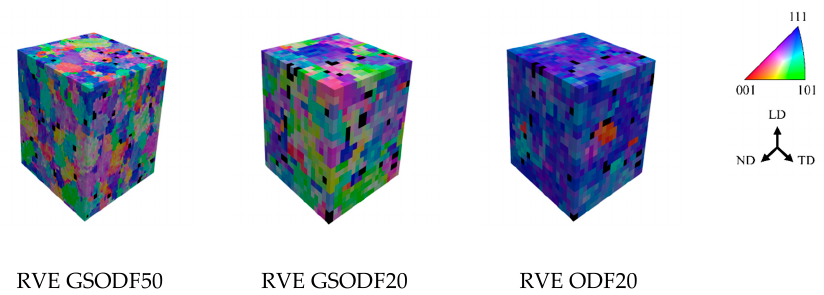
Figure 11. Deformed RVEs after DAMASK simulation under uniaxial tension (deformation: 15%). IPF colors (ND direction), carbides in black. Crystals 2020 , 10 , x FOR PEER REVIEW